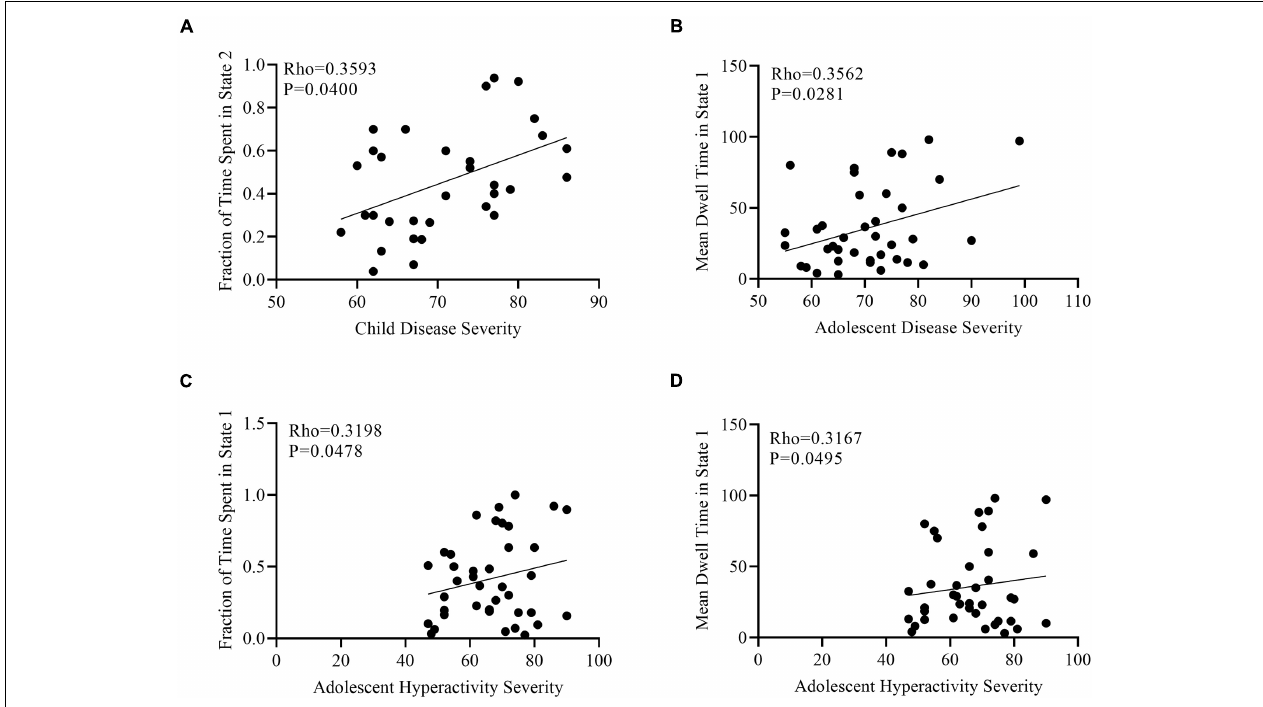
FIGURE 7 | Scatter plots of the correlation analyses. (A) Positive correlation between fraction of time spent in state 2 and child disease severity. (B) Positive correlation between mean dwell time in state 2 and adolescent disease severity. (C) Positive correlation between fraction of time spent in state 1 and adolescent hyperactivity severity. (D) Positive correlation between mean dwell time in state 1 and adolescent hyperactivity